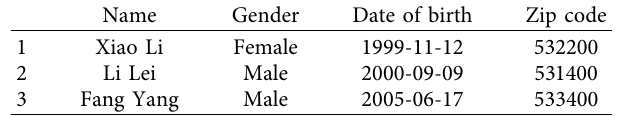
Table 1: Original object information table.